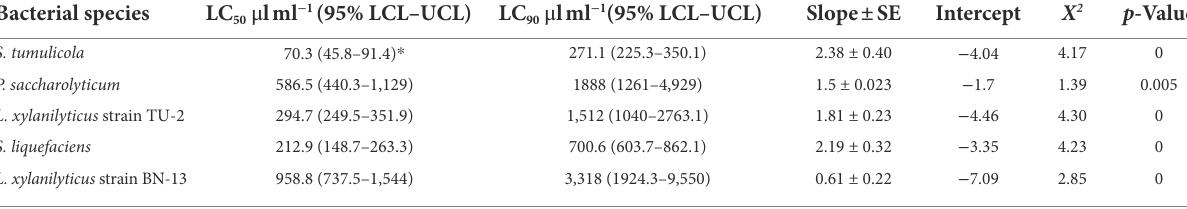
* Each figure represented as a power of 10. LC 50 , lethal concentration that kills 50% of insects; LC 90 , lethal concentration that kills 90% of insects; LCL, lower confidence limit; UCL, upper confidence limit; X 2 , Chi-square value; SE, standard error; and p -value, probability.